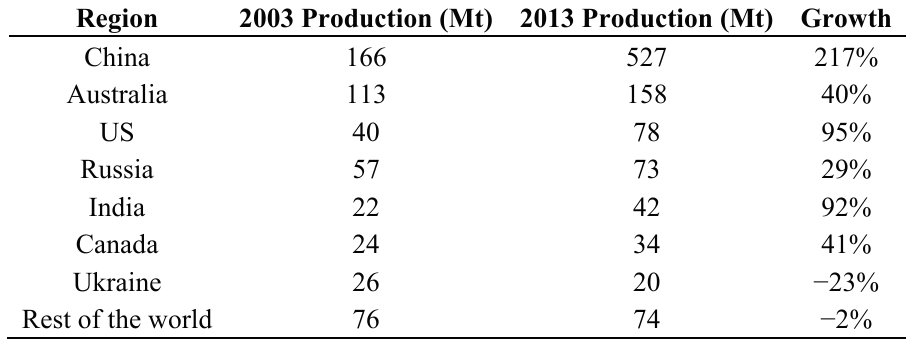
Figure 6. World metallurgical coal production over the past decade [21]. Table 3. Metallurgical coal annual production comparing 2003 and 2013